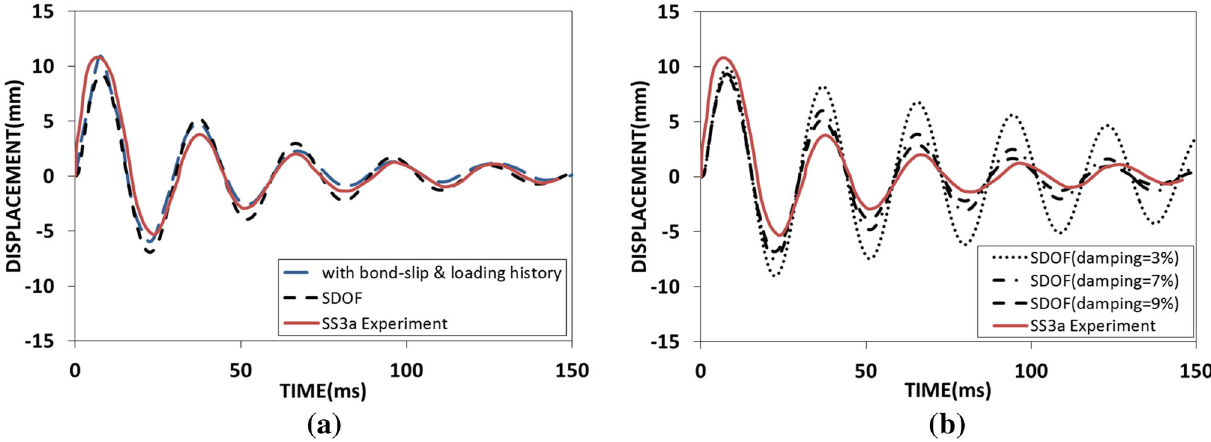
Fig. 15 Mid-span deflection time history including SDOF for